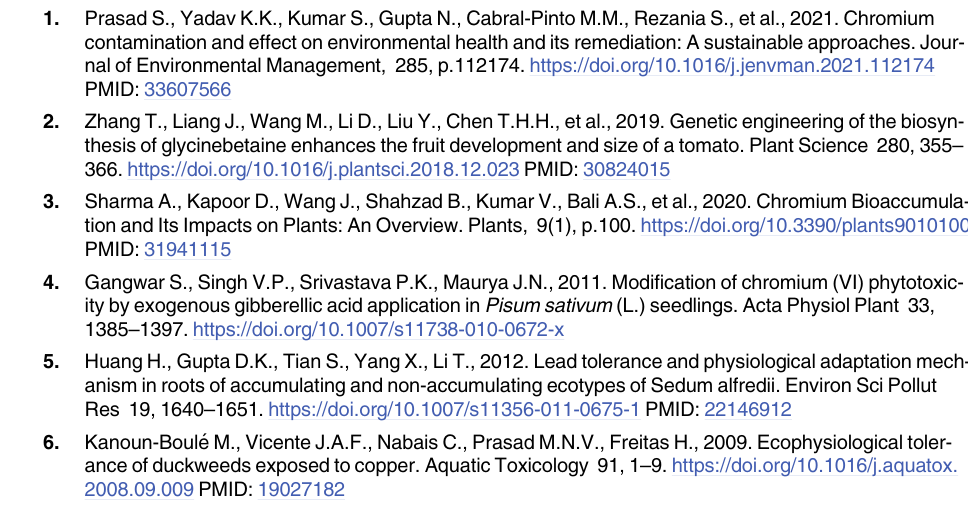
S34 Table. Effect of GB spiked in soil and AMF treatments on proline ( μ g/g fresh weight) in sorghum under Cr toxic stress at 95